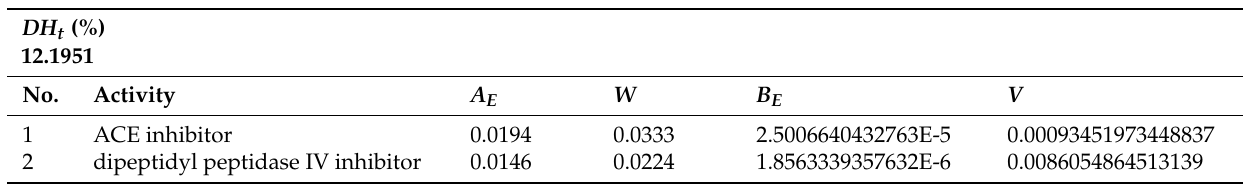
Table A6. A E , DH t , W , B E and V values from RubisCO of Halophila stipulacea . In silico enzymatic cleavage carried out by using pepsin.